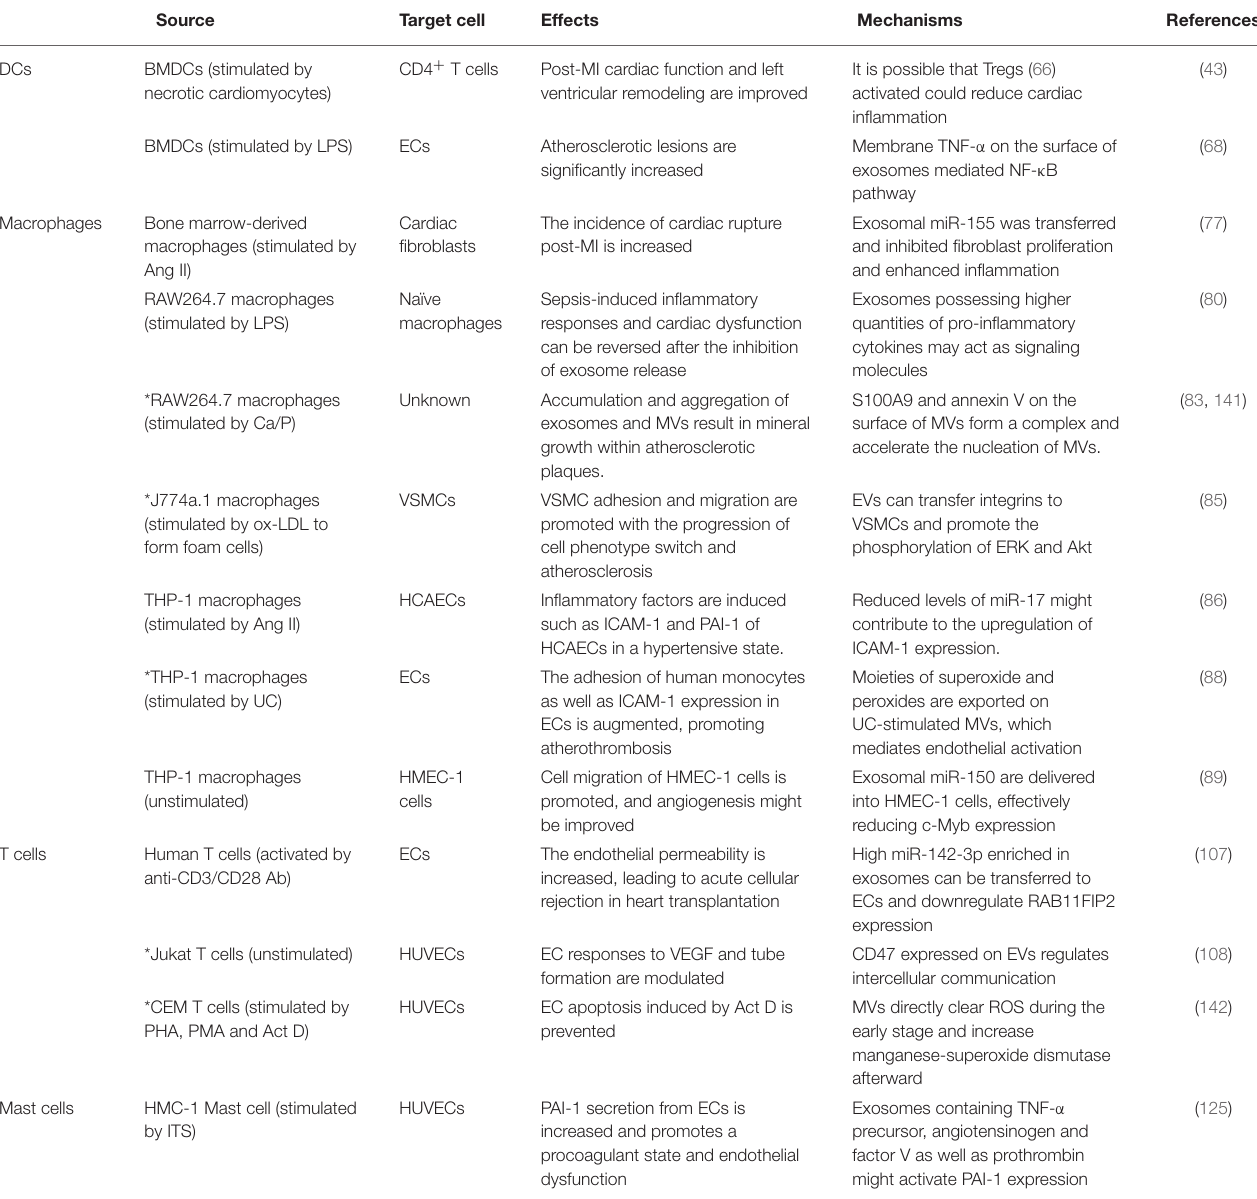
TABLE 3 | Summary of exosomes derived from immune cells in cardiovascular